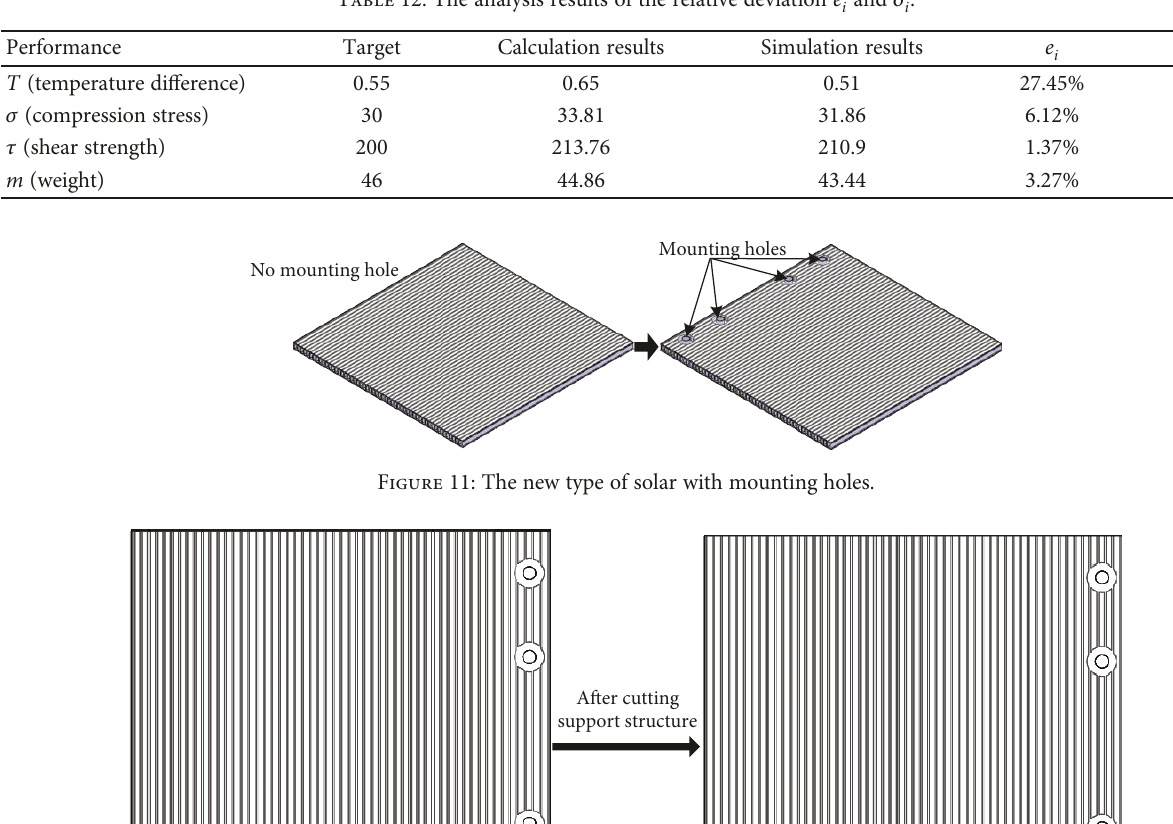
Table 12: The analysis results of the relative deviation e